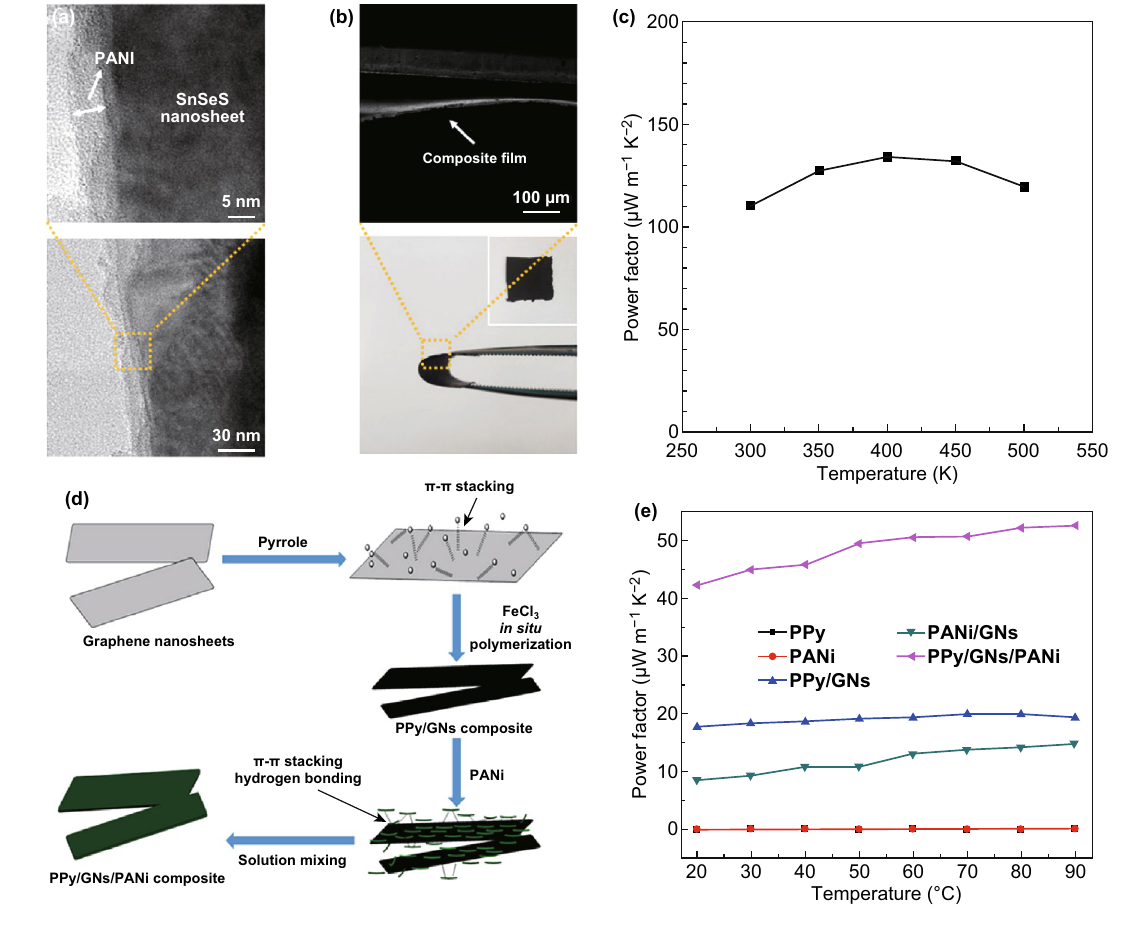
Fig. 12 a TEM image of the SnSe 0.8 S 0.2 nanosheets, b SEM image of the PANI-coated SnSe 0.8 S 0.2 film and c power factor of the PANI-SnSeS nanosheet/PVDF composite film with a PANI-SnSeS nanosheet-to-PVDF ratio of 2:1 as a function of temperature. Reproduced with permission from Ref. [212]. Copyright 2018, American Chemical Society. d Schematic process of the polypyrrole/graphene/polyaniline ternary nanocom- posite and e its power factor. Reproduced with permission from Ref. [220]. Copyright 2017, American Chemical